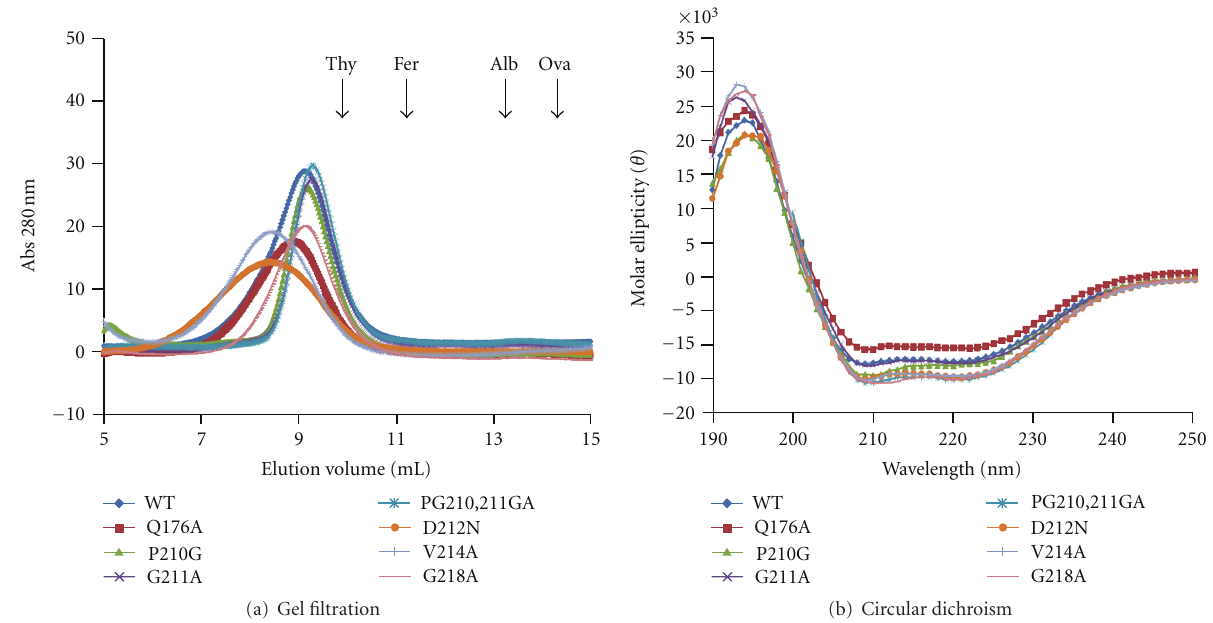
Figure 2: MCM mutant proteins retain their overall structural integrity. (a) Gel filtration analysis of wild-type and mutant proteins was performed as described in “Section 2”. The elution positions of size markers are shown: Thyroglobulin (Thy, 670,000Da), ferritin (Fer, 440,000Da), albumin (Alb, 67,000Da) and ovalbumin (Ova, 45,000Da). (b) Circular dichroism measurements were performed as described in “Section 2”.